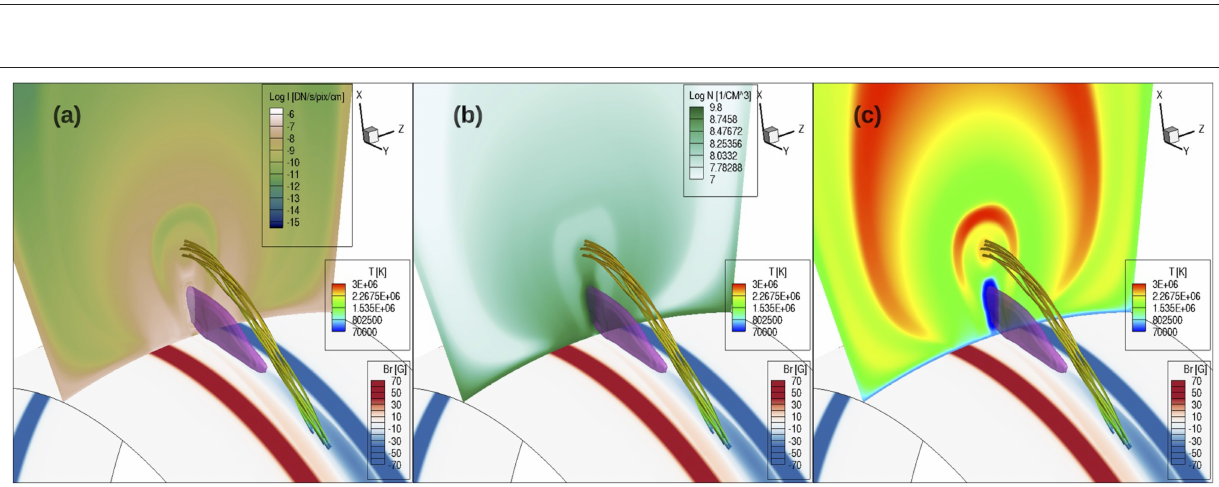
Frontiers in Astronomy and Space Sciences |